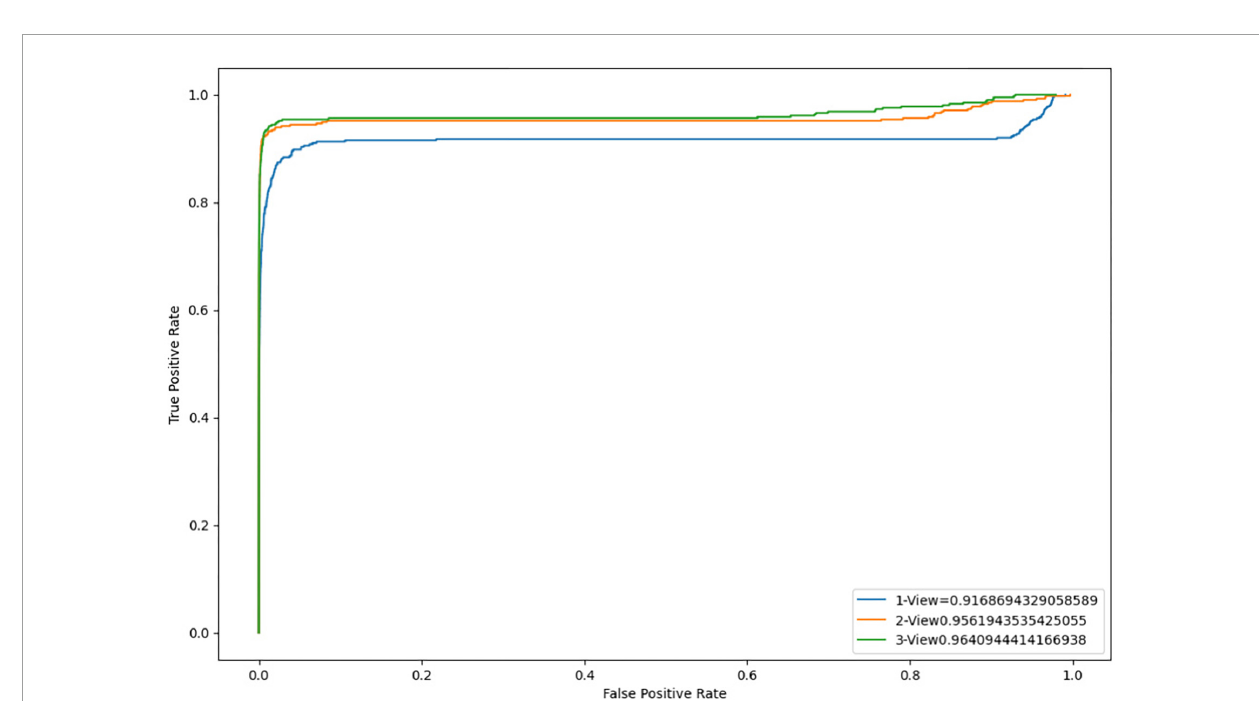
FIGURE8 Receiver operating characteristic (ROC) curves for one, two, and three view